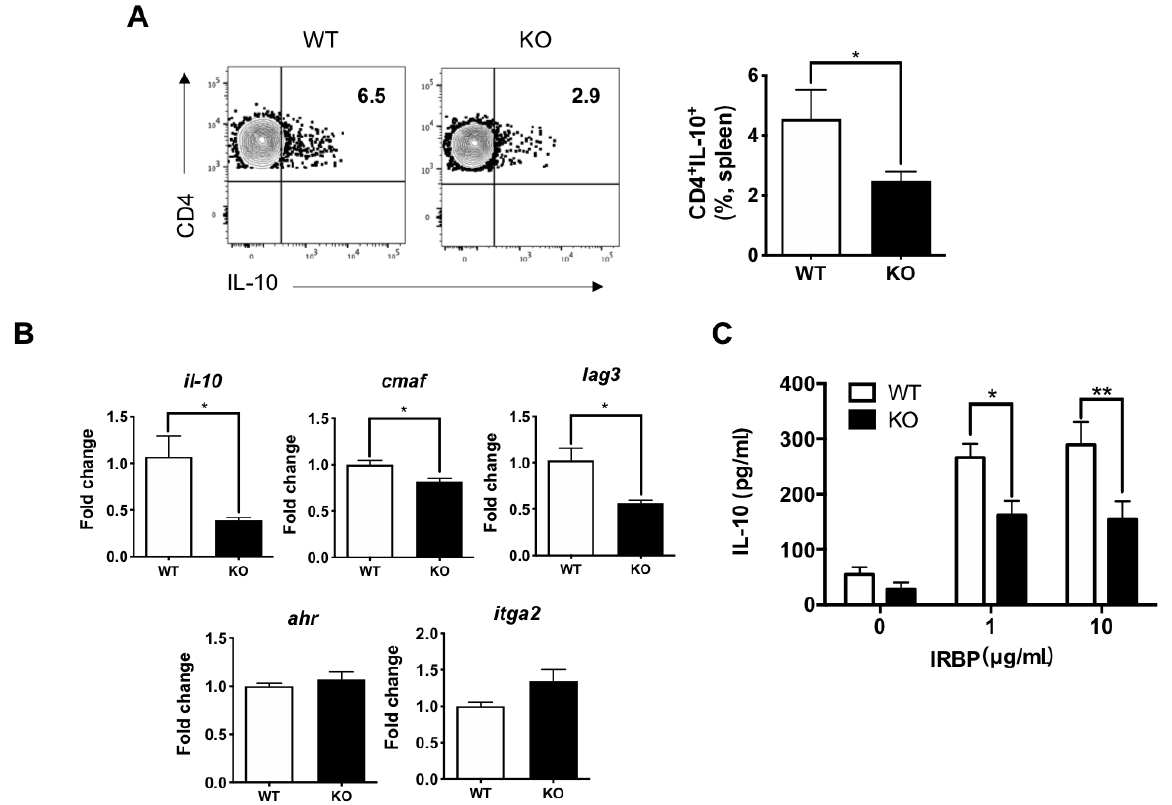
Figure 6. Deficiency of IL-27R α a impaired Tr1 cell induction. ( A ) Representative plots and frequency of IL-10-producing 图 6 CD4 + T cells in the spleens from WT and KO EAU mice. Data represent the means ± SEMs of two experiments (WT: n = 5 mice; KO: n = 7 mice). * p < 0.05, Mann–Whitney U test. ( B ) The relative gene expression of il-10 , cmaf , lag3 , ahr , and itga2 in CD4 + T cells sorted from the spleens of WT and KO EAU mice. Total RNA was extracted from CD4 + T cells that were sorted from the spleens of EAU mice on day 21 post-immunization. Data represent the means ± SEMs from a representative of two independent experiments (4 mice per group). * p < 0.05, Mann–Whitney U test. ( C ) Retinal antigen-specific IL-10 production in dLNs of WT and KO EAU mice. Lymphocytes from dLNs of EAU mice were isolated and stimulated with IRBP for 48 h. Cultured supernatants were collected for cytokine determination by ELISA. Data represent the means ± SEMs of three experiments (WT: n = 9 mice; KO: n = 10 mice). * p < 0.05, ** p < 0.01, two-way